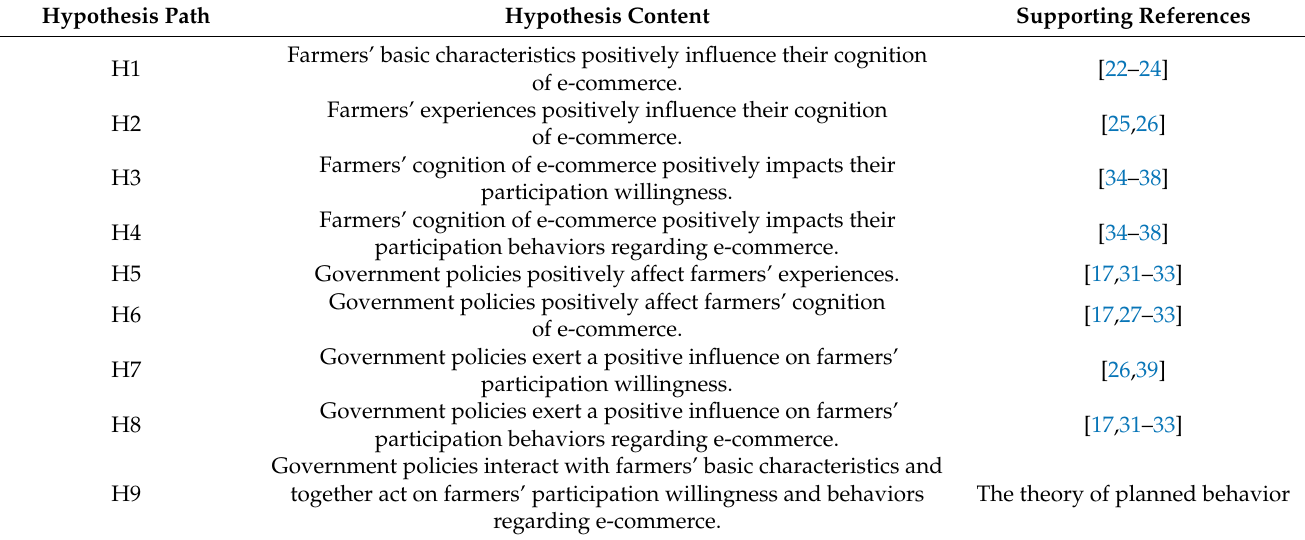
Table 1. Research hypotheses.